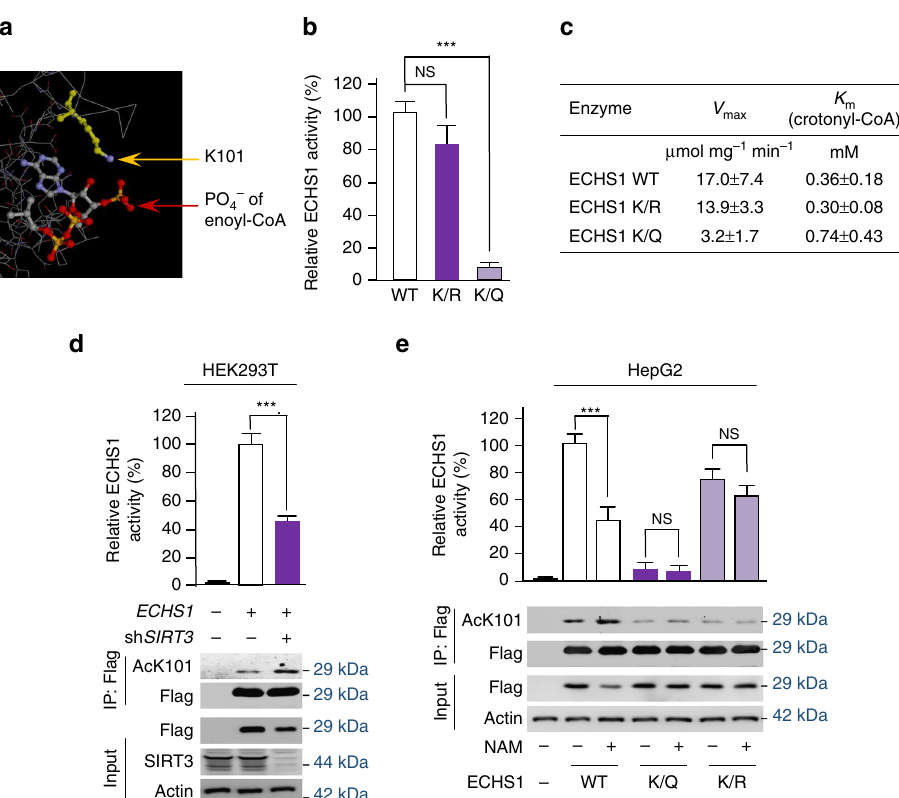
Fig. 4 Acetylation inactivates ECHS1. a The crystal structure shows that K101 is involved in enoyl-CoA binding. Arrows point to the amine on lysine ( yellow ) and the phosphate on enoyl-CoA ( red ). b The relative speci fi c activities of ECHS1 wild-type (set as 100%), K/R, and K/Q mutants were determined. Mean values with SD are reported. NS not signi fi cant; *** P < 0.001. c The V max and K m were determined for wild type ECHS1, K/R, and K/Q mutant using crotonyl-CoA as the substrate. d The activities of ECHS1 expressed in HEK293T or SIRT3 knocked down HEK293T cells were determined. e The K101 acetylation levels and relative speci fi c activities of Flag-tagged wild type, K/Q, and K/R mutant ECHS1 expressed in HepG2 cells cultured in the presence or absence of NAM (5 mM). The average speci fi c activities ( n = 3) with SD and representative western blots are